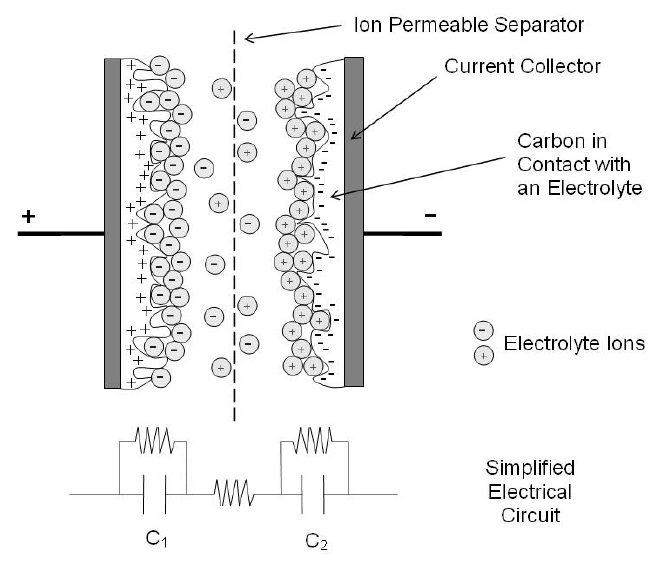
Figure 2 . Representation of a charged electrochemical double layer capacitor